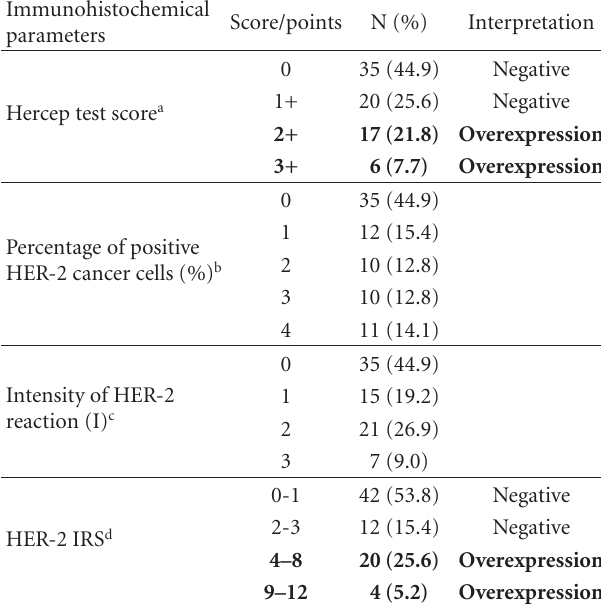
Table 2: Parameters of HER-2